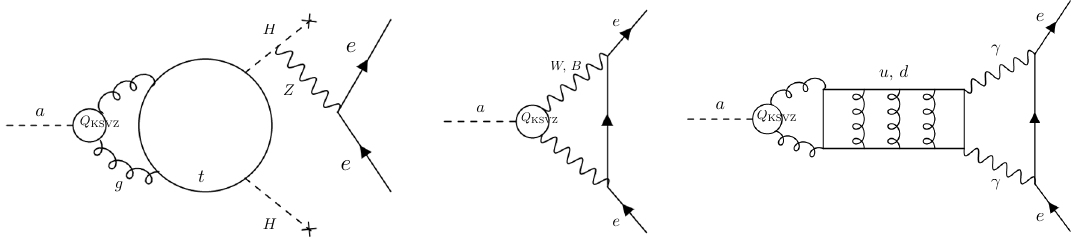
Figure 3 . Diagrams for the radiative corrections to the axion-electron coupling C e in KSVZ- like